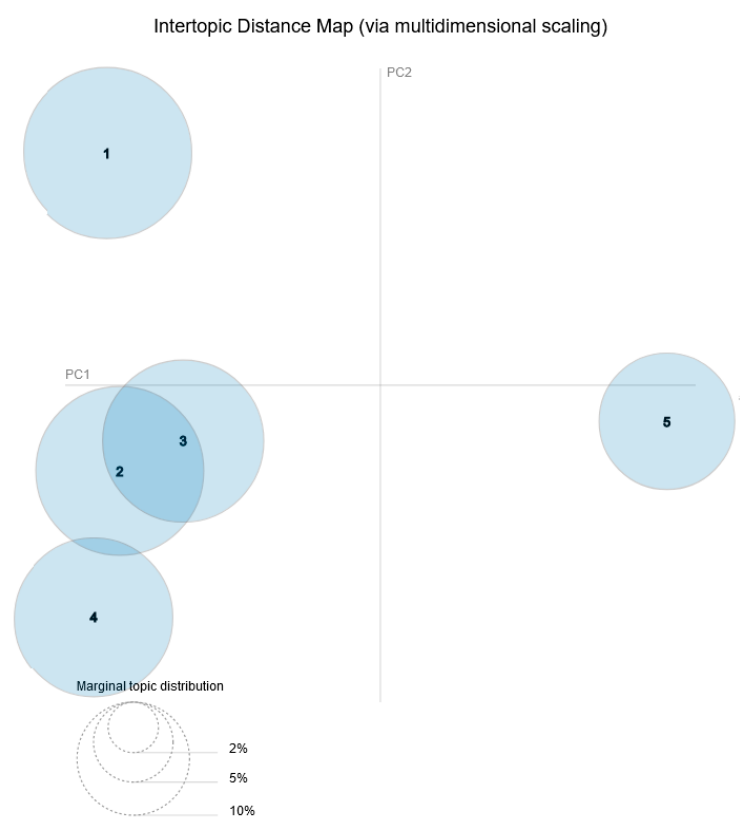
Figure 1. Intertopic Distance Map (via multidimensional scaling).